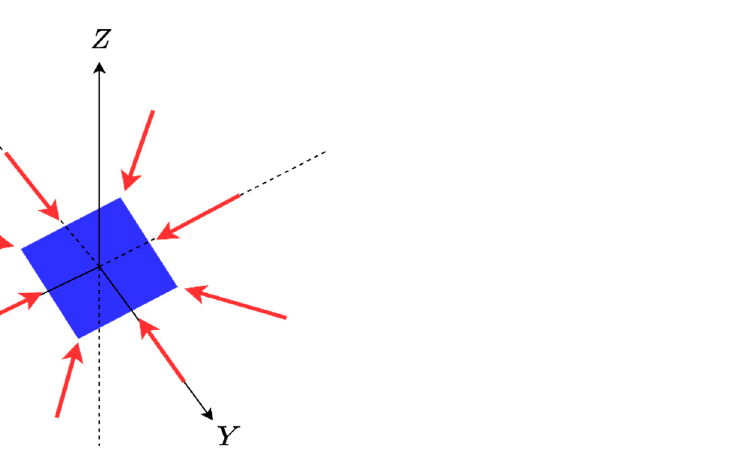
Figure 11. The eight directions of incident plane waves(shown as red arrows) for a XY face ID.